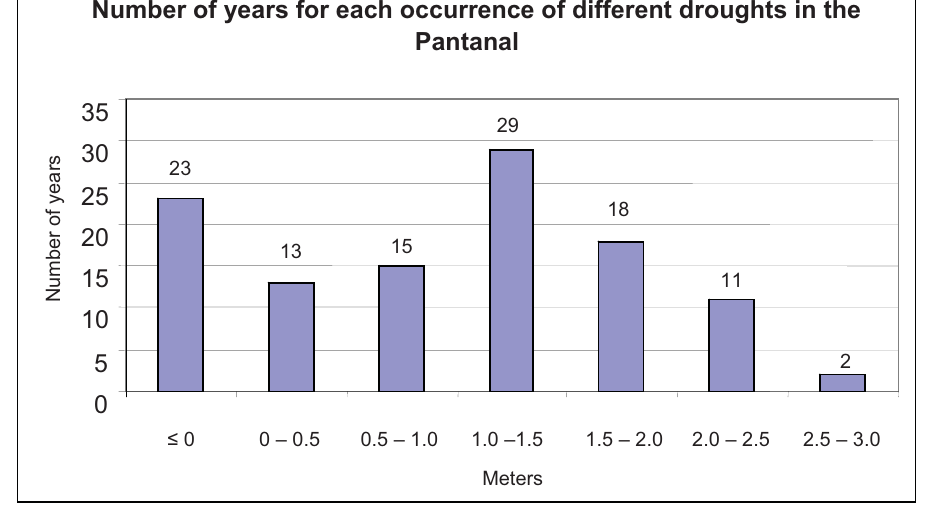
Figure 4. Number of years that droughts occurred in the Pantanal, as recorded on the Paraguay River at Ladário